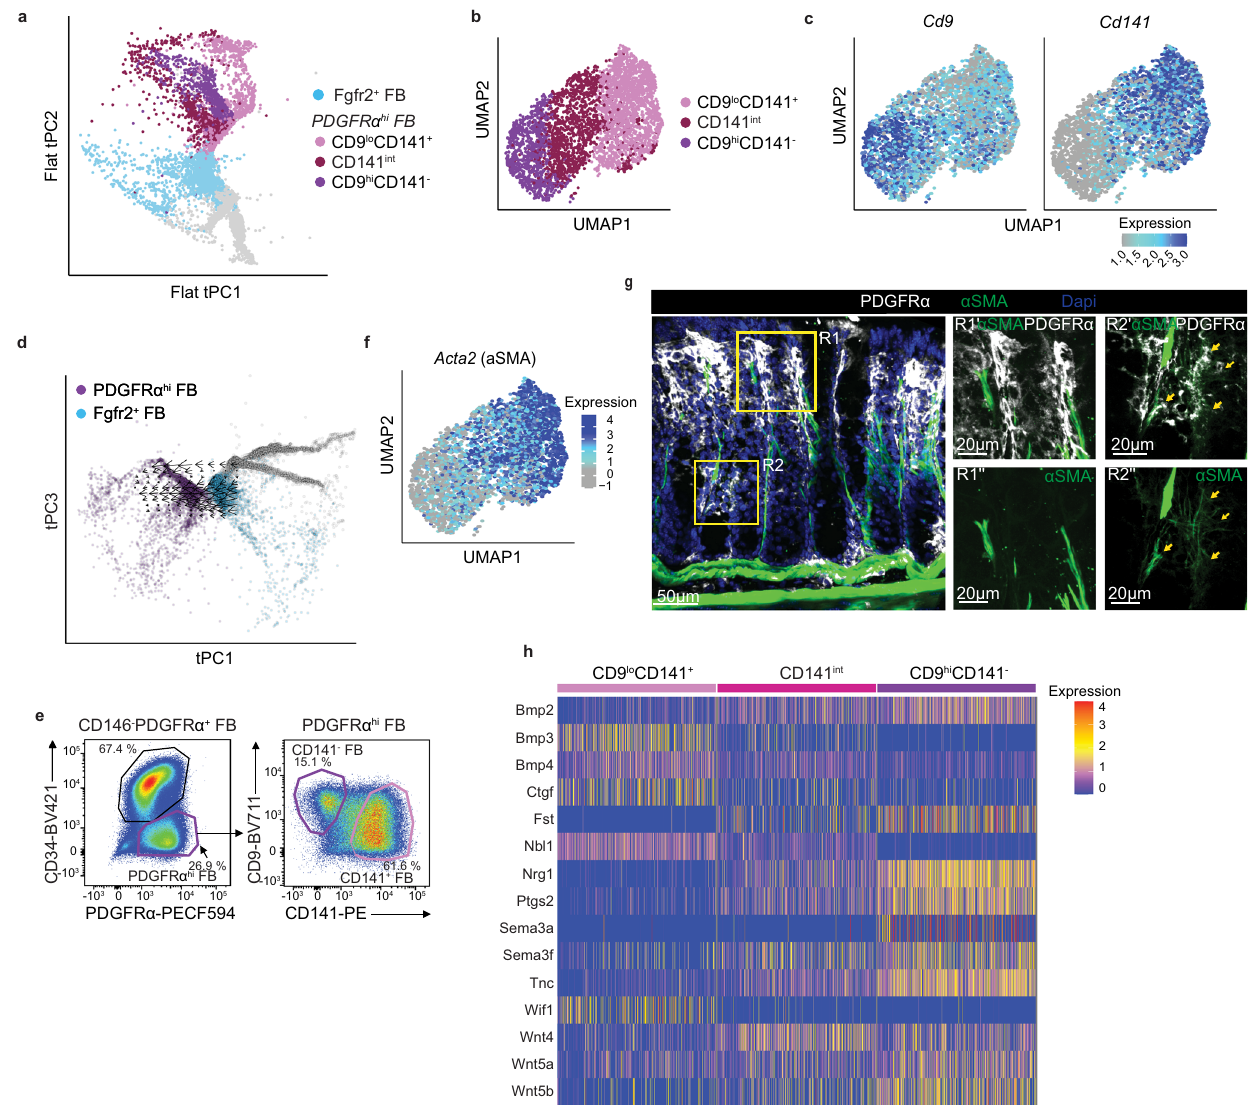
Fig. 6 | Colonic PDGFR α hi FB may arise directly from Fgfr2 + FB and consist of three transcriptionally distinct clusters. a tSPACE projection of colonic MSC in tPC1 – 3 embedded into 2D space, highlighting Fgfr2 + FB, together with three PDGFR α hi FB clusters. b UMAP dimensionality reduction of re-clustered colonic PDGFR α hi FBdepictingthethreeindicatedsubclustersand c expression ofCd9 (left panel) and Cd141 (right panel) overlaid onto the UMAP in ( b ). d tSPACE projection ofadultcolonicMSCintPC1and3,highlightingFgfr2 + FBandPDGFR α hi FBoverlaid with RNA velocity estimates. e Representative fl ow cytometric analysisof CD9 and CD141expressionbycolonicPDGFR α hi FB.Representativeplotsfrom2experiments